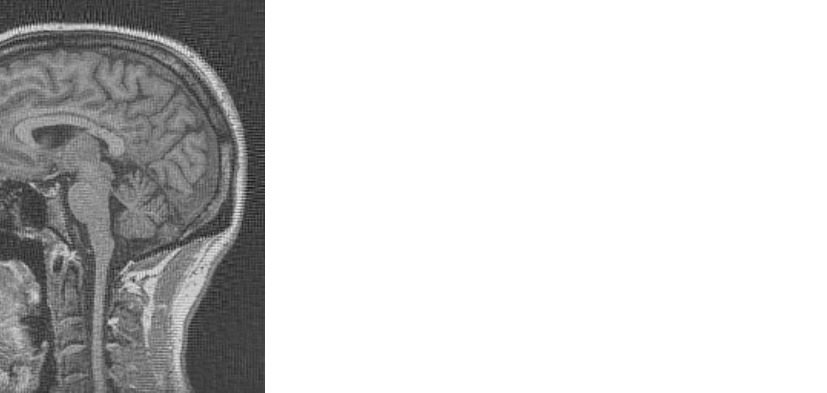
Figure 9. Extended backprojection from previous figure, filtered assuming there is a unique im- pulse response.